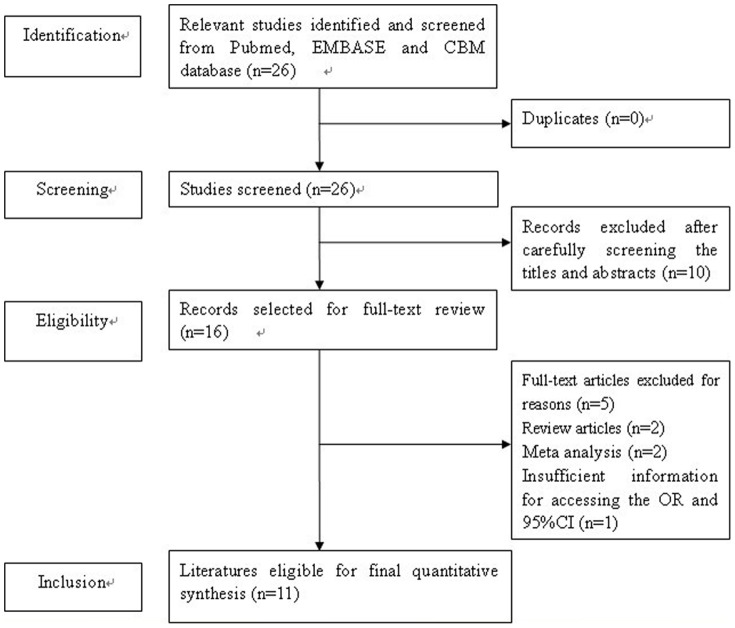
Flow diagram of included studies for this meta-analysis.